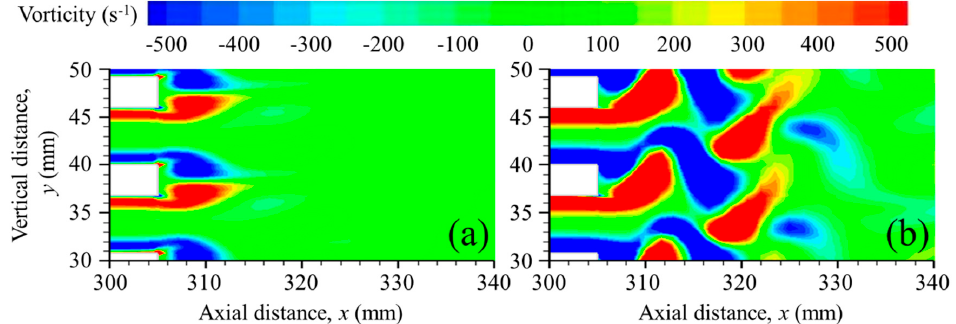
Figure 17. CFD predictions of vorticity contours at the end of the cold heat exchanger for phase ϕ 8 at drive ratios of ( a ) 0.3% using the laminar model and ( b ) 0.83% using the SST k- ω model. Distances x and y measured from an arbitrary